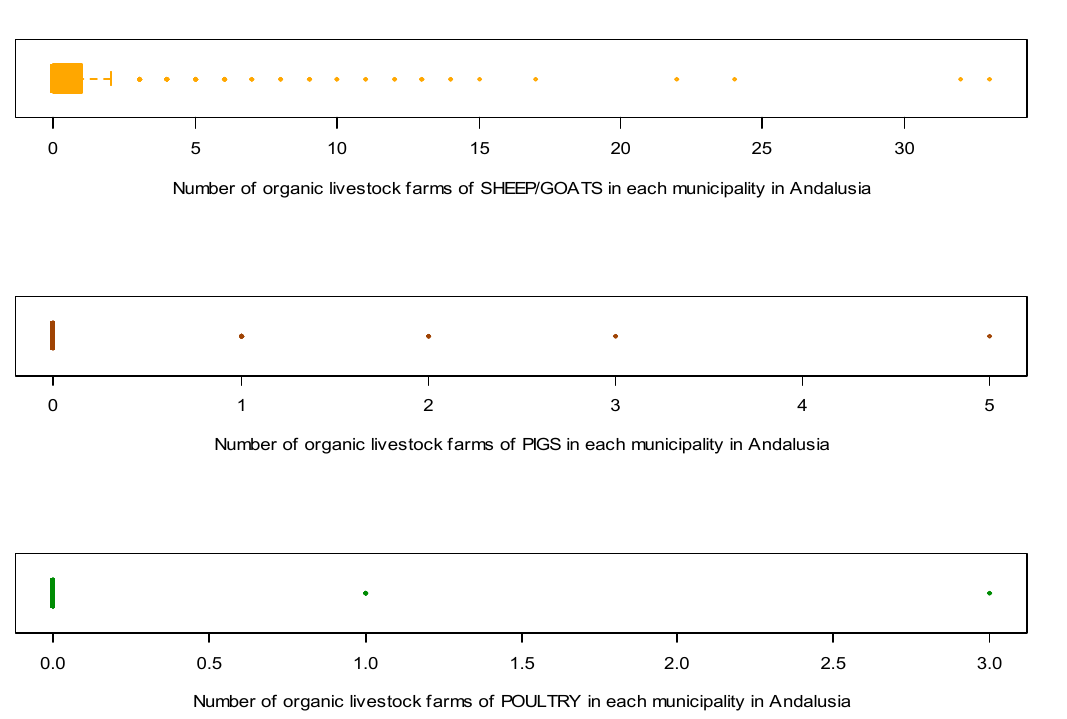
Figure 5. Box plot of total organic livestock farms by class of animal. All distributions are highly asymmetric, especially those for pig and poultry farms. The standardized skewness is 66.59 for sheep and goat farms, 86.24 for cattle farms, 96.35 for pig farms and 152.53 for poultry farms.